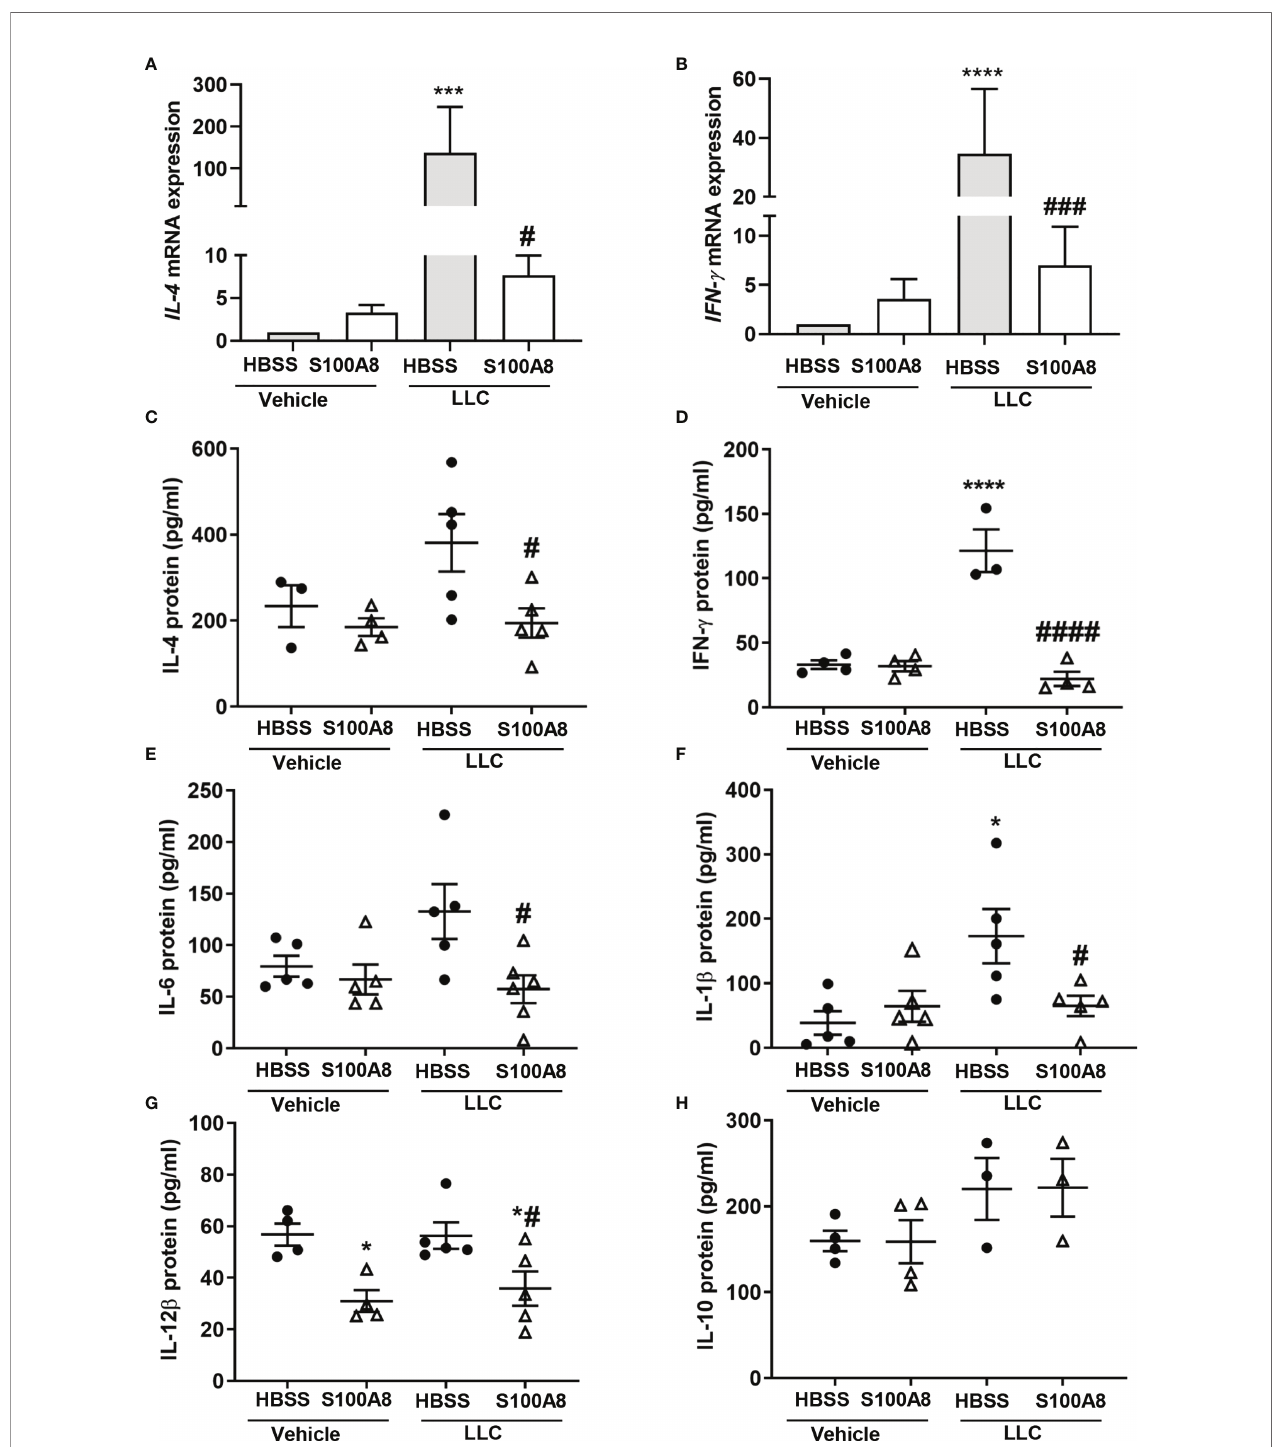
FIGURE 3 | Inhalation of S100A8 suppressed cytokine expression in lungs of mice with orthotopic lung tumors. (A, B) Graphs showing mean fold-changes ± SEM of IL-4 (A) and IFN- g (B) gene expression in lung tissues from mice treated with recombinant mouse S100A8 on Days 3, 6 and 9 post-LLC cell implantation and collected on day 10. Mice treated with HBSS served as controls, n = 4-5 mice per treatment group. (C, H) Graphs showing mean protein concentrations ± SEM (pg/ml) of IL-4 (C) , IFN- g (D) , IL-6 (E) , IL-1 b (F) , IL-12 b (G) and (H) IL-10 in bronchoalveolar lavage fl uid from mice treated with S100A8 on Days 3, 6 and 9 post-LLC cell implantation and harvested on day 10. Mice treated with HBSS served as controls. *p < 0.05, ***p < 0.001 and ****p < 0.0001 compared to HBSS + vehicle; # p < 0.05, ### p < 0.001 and #### p < 0.0001 compared to HBSS +